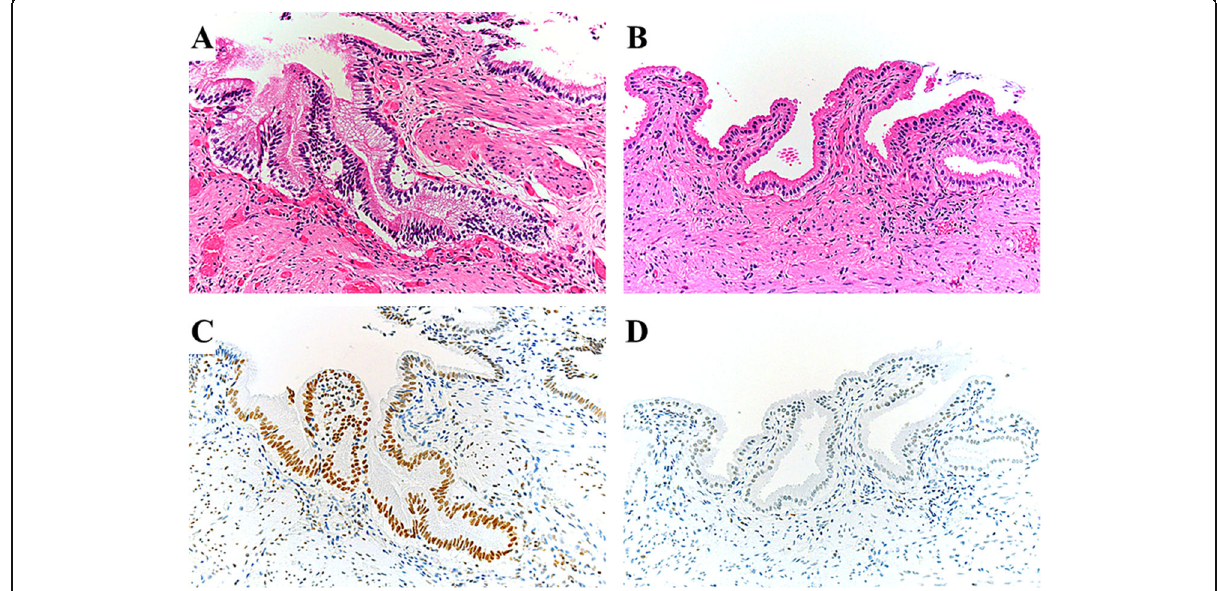
Fig. 1 γ H2AX expression in the gallbladder tissue of patients with and without pancreaticobiliary maljunction (PBM). Representative hematoxylin- eosin-stained images of ( A ) PBM tissue and ( B ) control tissue. Immunohistochemical staining of γ -H2AX in ( C ) PBM tissue and ( D ) control tissue. Strong staining of γ -H2AX was observed more frequently in the gallbladder epithelium of PBM cases, whereas weak staining was predominantly found in control cases. γ -H2AX, phosphorylated H2AX at Ser139 (200x